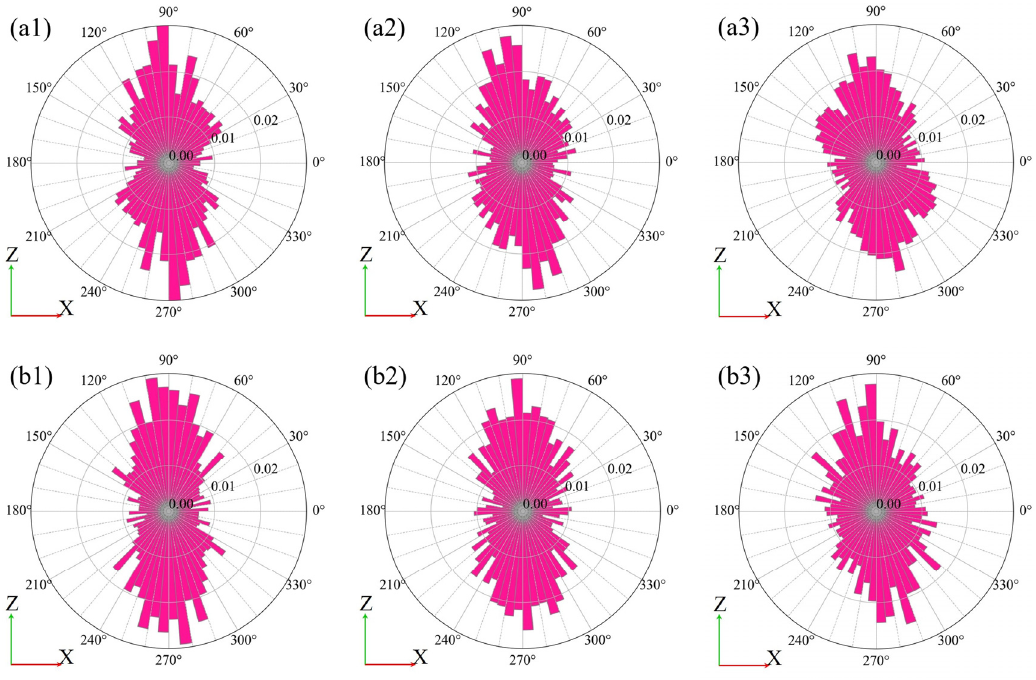
Figure 17. Histograms of particle direction of the short axis on the vertical plane (XZ plane): ( a1 – a3 ) are G5; ( b1 – b3 ) are G4. The left columns represent S0 (initial state), center columns represent S2 (D h = 3 mm), and right columns represent S4 (D h = 8 mm). D h , horizontal displacement.